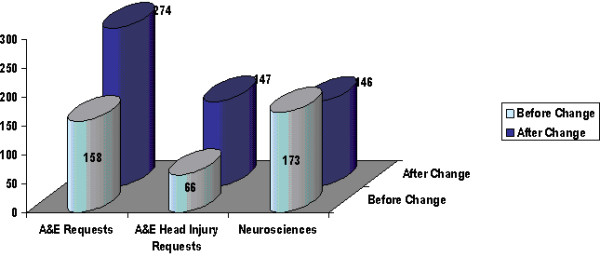
A diagrammatic representation of the change in referral patterns over the two three month periods included in the study.